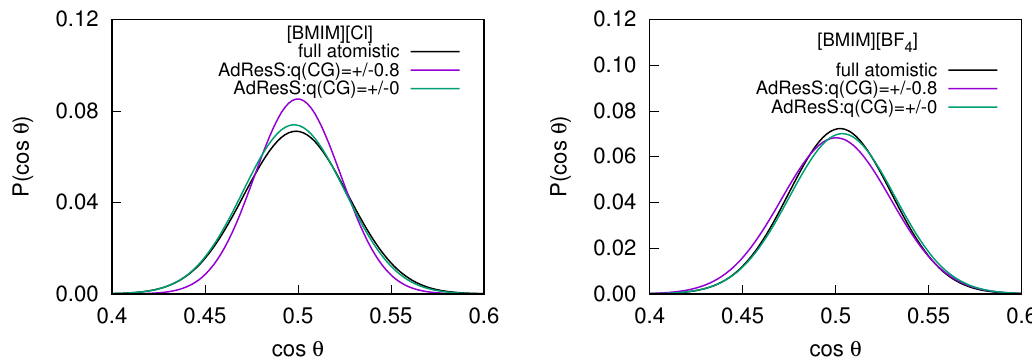
Figure 4. The probability distribution of the averaged order parameter | cos θ | in the atomistic region of the 2 nm AdResS simulations compared with the corresponding quantity in the equivalent sub-region of the full atomistic simulation for the [ BMIM ][ Cl ] − 1 ( left ) and [ BMIM ][ BF 4 ] − 1 ( right )